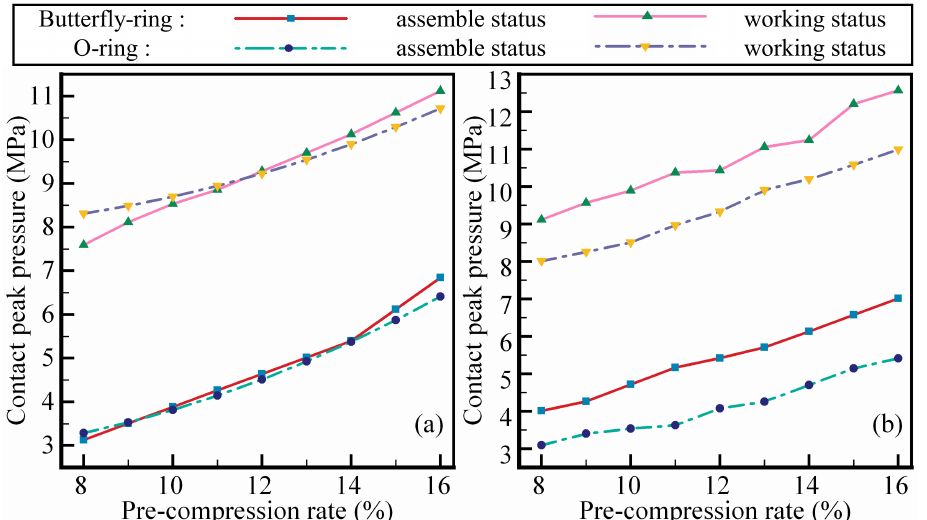
Figure 11. Verification of the proposed butterfly-ring. The comparisons of contact peak pressure between O-ring and butterfly-ring are made at piston rod side in ( a ) and at groove side in ( b ), with nine different pre-compression rates. Moreover, the contact peak pressure of O-ring and butterfly-ring under assemble status and working status are compared,